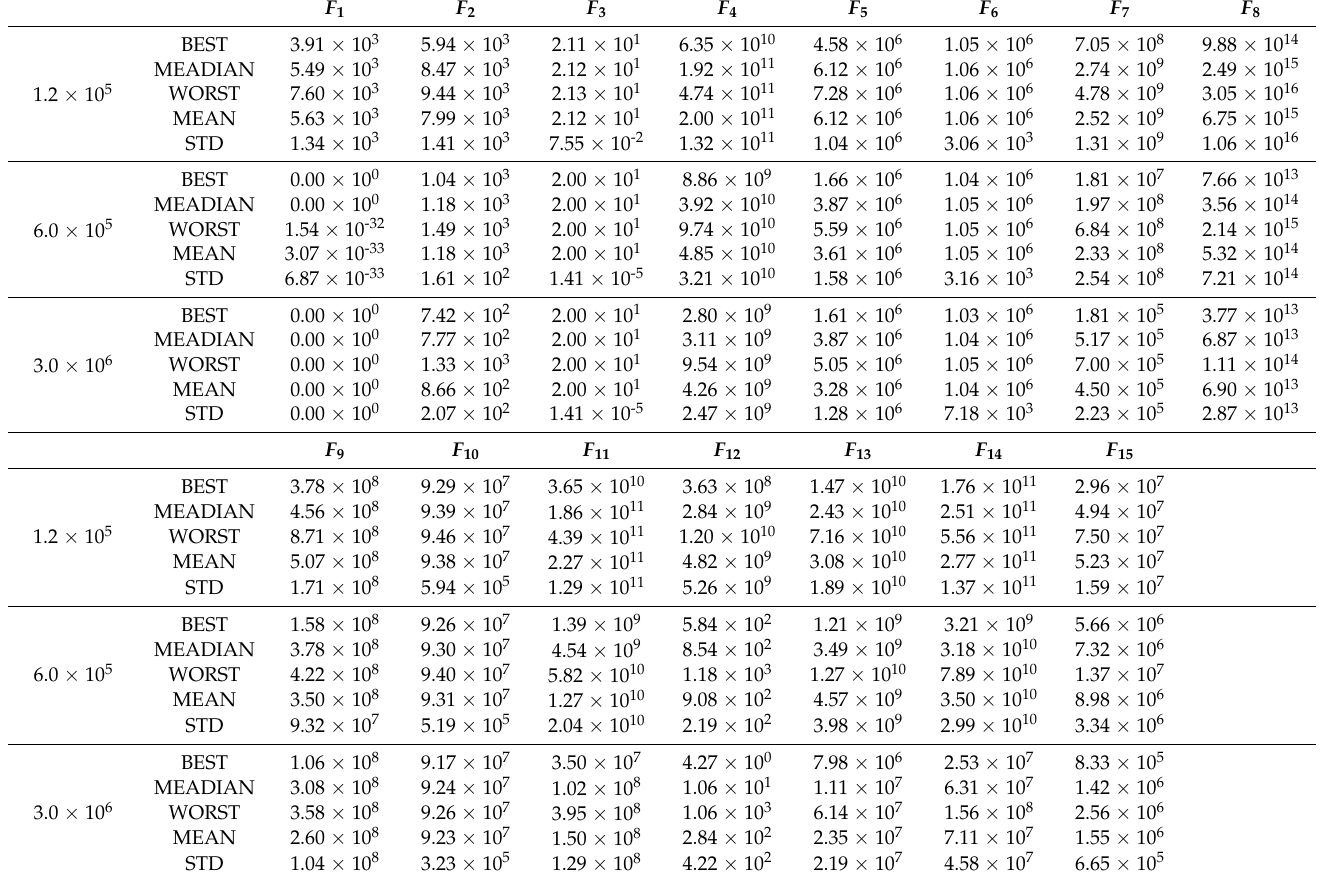
Table 12. Detailed results for the fine-tuned CC-SHADE-ML-LS1